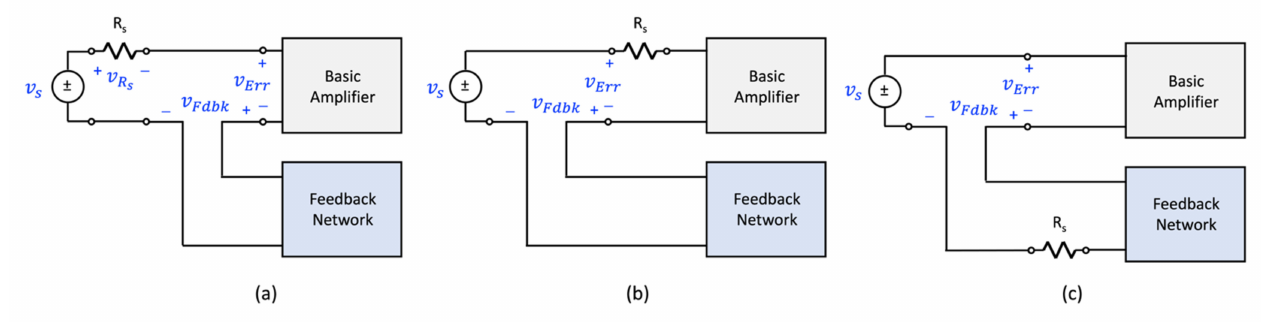
Figure 4. Three equivalent voltage-mixing arrangements; two are compliant with Black’s single-loop feedback structure: ( a ) noncompliant, ( b ) compliant, and ( c )